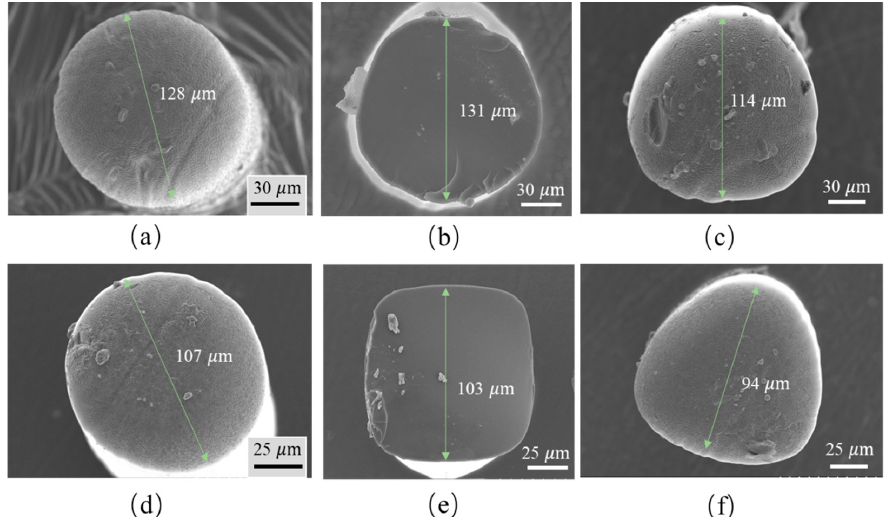
Figure 7. The results of 3D printing experiments. ( a ) the designed circle pattern, ( b ) the designed square pattern, ( c ) the designed triangle pattern, ( d ) the optimized circle pattern, ( e ) the optimized square pattern, ( f ) the optimized triangle